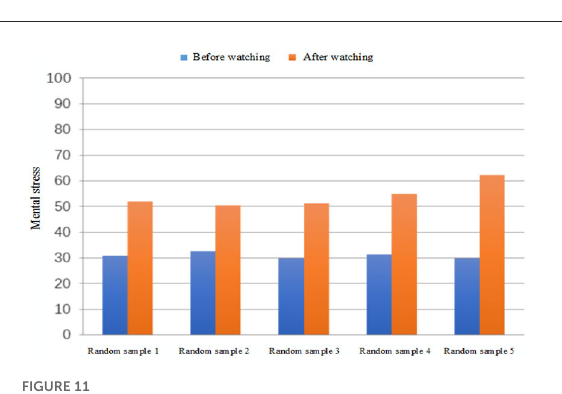
FIGURE10 Comparison of mental stress before and after exercise for random sample.